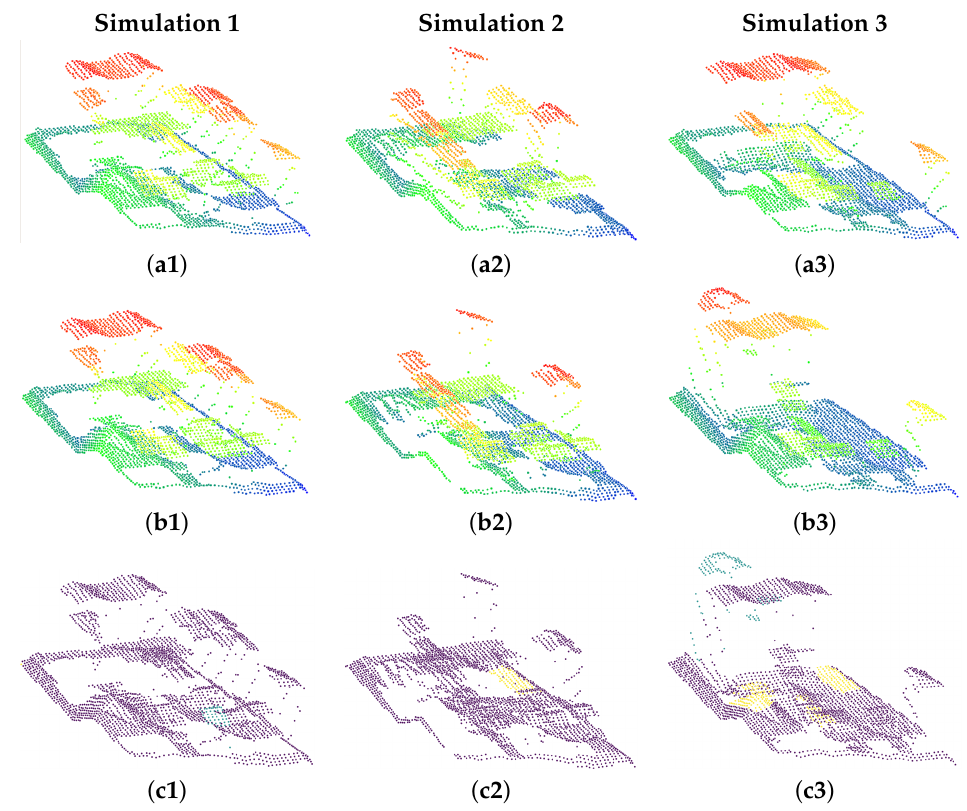
Figure 3. Three simulation results generated from the same district of Lyon. Elevation (relative to each PC) is shown in color for the first date ( a1 – a3 ) and the second date ( b1 – b3 ). The automatic annotations according to the change classes are presented in ( c1 – c3 ) with new buildings (blue), demolished buildings (yellow) and unchanged objects